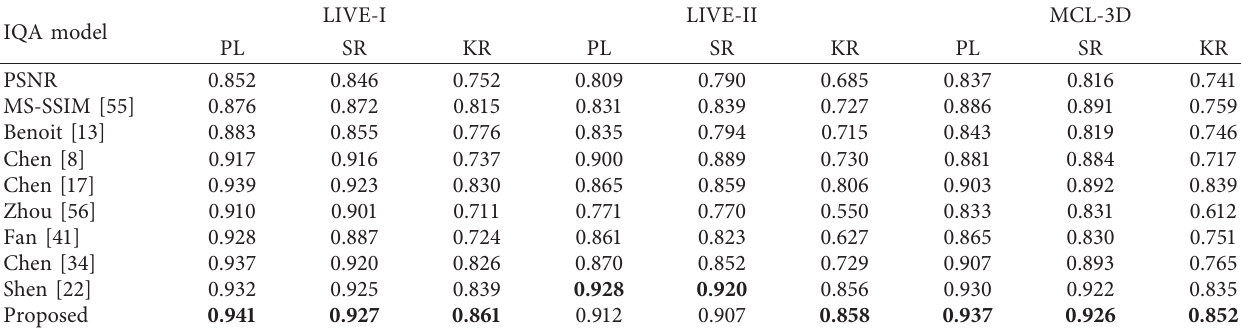
Table 1: Performance of the proposed scheme and other methods in terms of PLCC, SRCC, and KRCC, using the three databases. IQA model